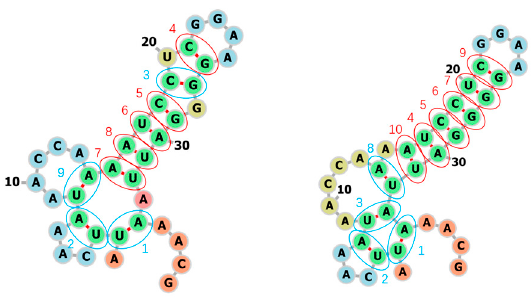
Figure 16. The other two predicted secondary structures and folding paths of bpRNA_RFAM_25409. The blue circle indicates the wrong prediction, the red indicates the correct prediction, and the numbers next to it indicate the order of base pair formation or folding paths.